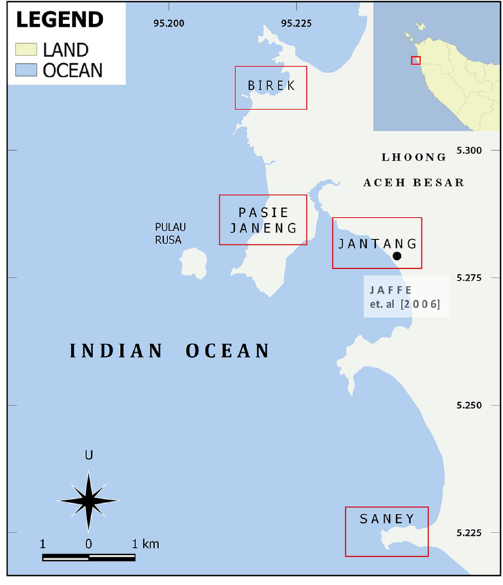
Figure 1. Field survey sites at Lhoong, Aceh Besar, Sumatra, ap- proximately 40km south of Banda Aceh,